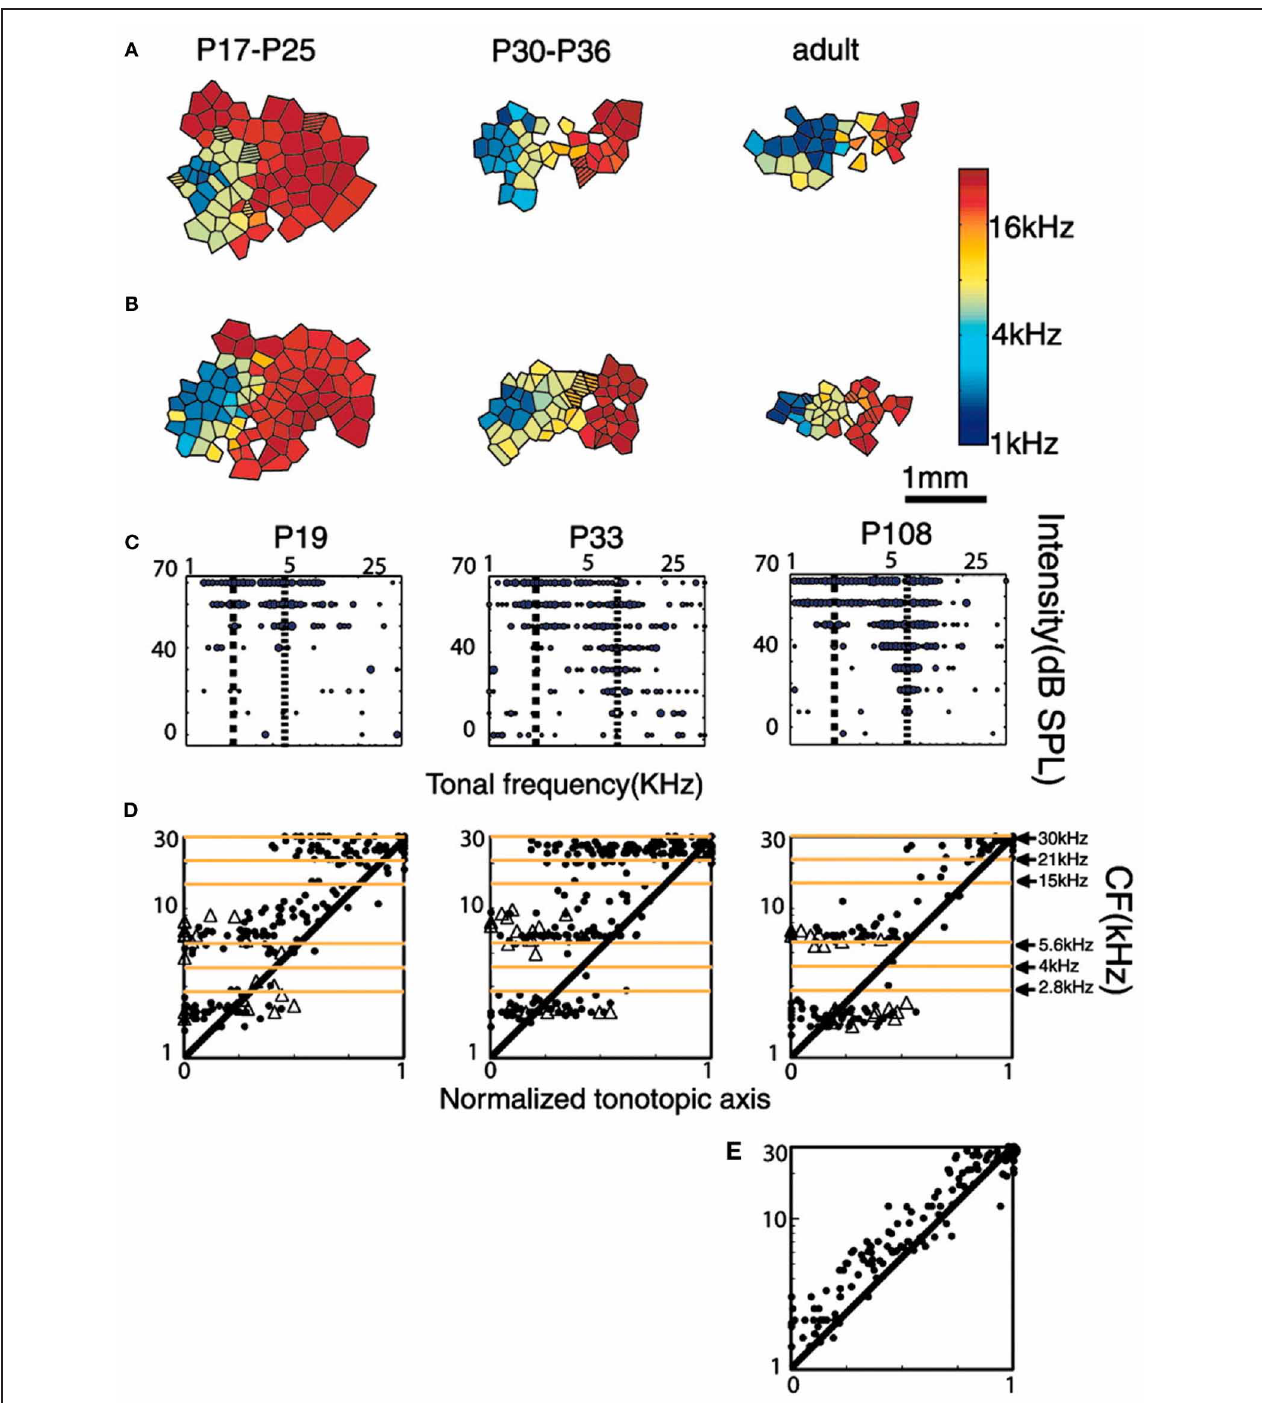
frequencies of secondary peaks ( ρ ) along the tonotopic axis of the auditory cortex at different developmental stages. Note the regions of tonal stimulation indicated at the right-most graph. Also note that especially for the low-frequency tones (2.8, 4, and 5.6kHz) the responses between 2.8 and 5.6kHz are suppressed and those below 2.8kHz and above 5.6kHz are enhanced. (E) Distribution along the tonotopic axis of the auditory cortex in control naive adult rats (P100). Reprinted from Nakahara et al. (2004), with permission from National Academy of Sciences,